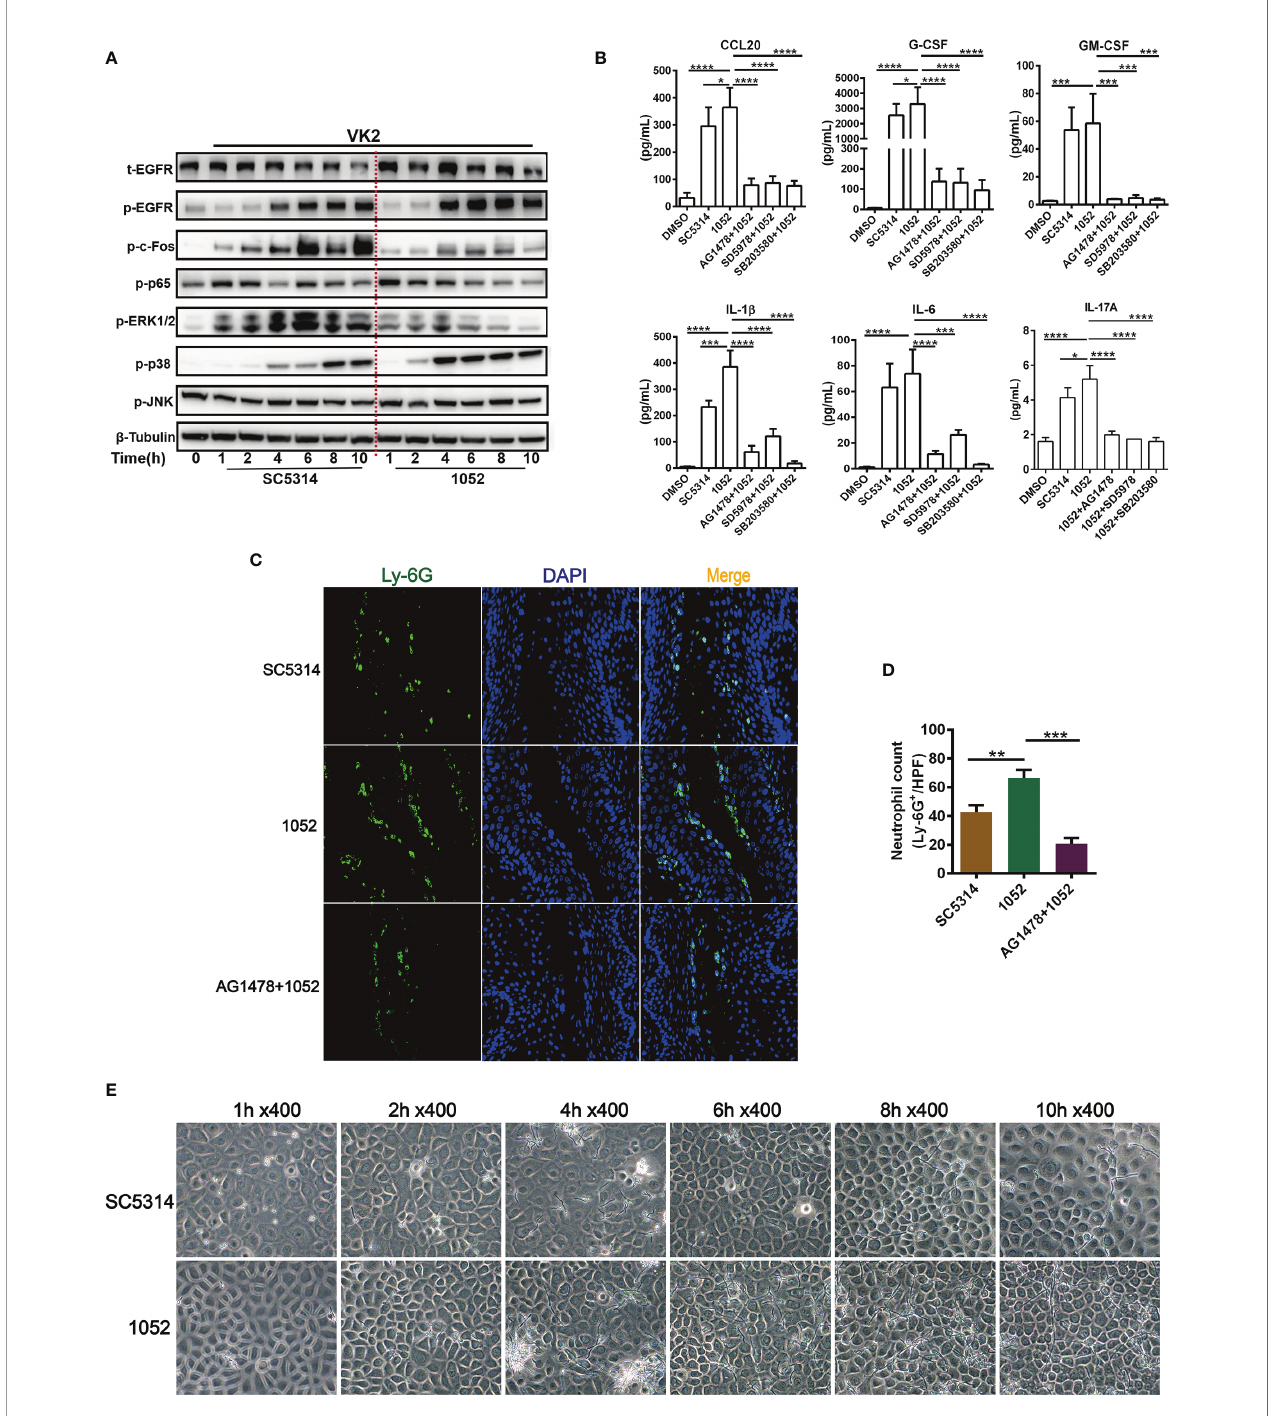
FIGURE 3 | Differential activation of EGFR and MAPK and cytokine induction by clinical isolate 1052 and WT strain SC5314. VK2/E6E7 cells were stimulated with SC5314 and clinical isolate 1052 (MOI=5) for the indicated time respectively. Phosphorylation of EGFR, MAPK proteins, NF- k B (p65) and c-Fos was detected by immunoblotting of cell lysates (A) . 1052 induced higher levels of cytokines secretion (CCL20, G-CSF, GM-CSF, IL-1 b , IL-6, IL-17A) than SC5314. All inhibitors (EGFR, p38 and ERK1/2 inhibitor) suppressed 1052-induced secretion of CCL20, G-CSF, GM-CSF, IL-1 b , IL-6 and IL-17A (B) . Infection with 1052 in the vaginal mucosa of mice induced signi fi cantly increasedneutrophil recruitment at the infection foci whencomparedwithSC5314 and pre-treatment of AG1478 resultedinsigni fi cantly decreased neutrophil recruitment (C) . Numbers in graph (D) provide the mean neutrophils count per group (n=3/each group). Morphologyof SC5314 andclinical isolate 1052 adhering to VK2/E6E7 cells at 0, 1, 2, 4, 6, 8, 10 h post infection (E) , gentlywashed with PBS for at least 3 times. Data are representative of three independent experiments. Error bars represent SD, *p < 0.05, **p < 0.01, ***p < 0.001, ****p <